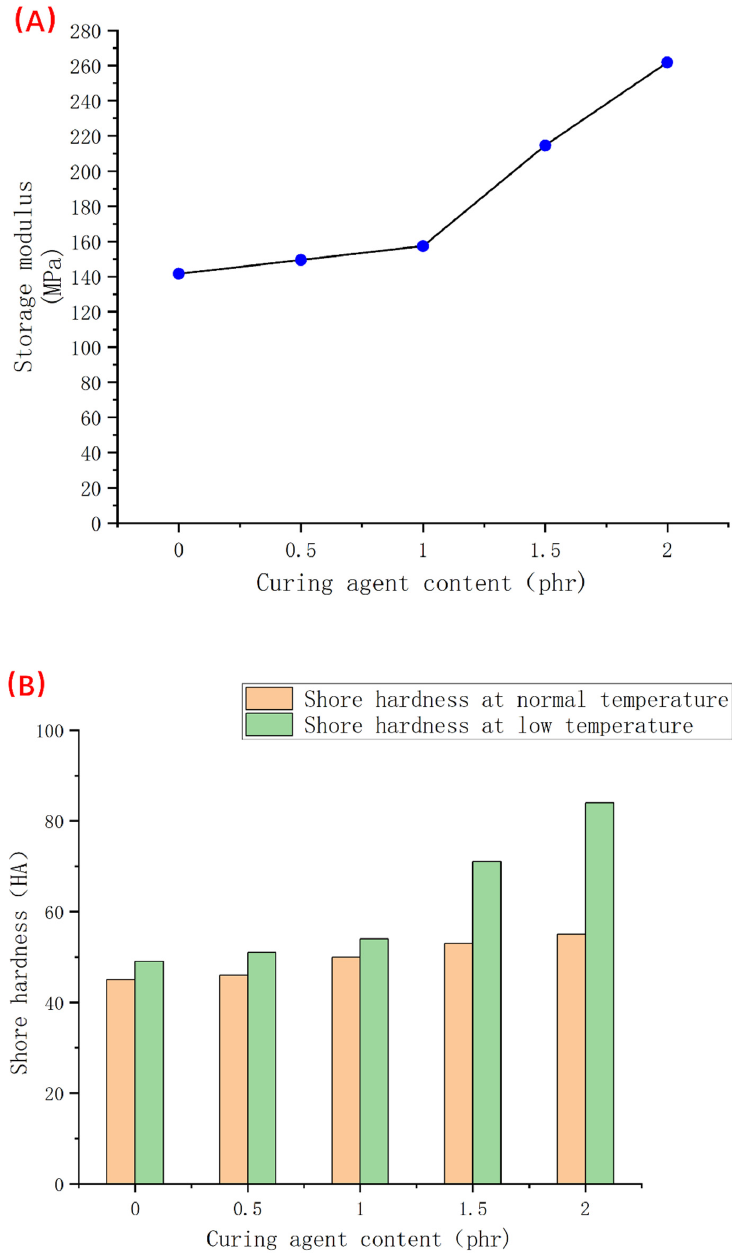
Figure 11. Low-temperature hardness change of samples 1–5 at − 60 ◦ C and broken line statistic diagram of the storage modulus at − 60 ◦ C (( A ) is the broken line statistic diagram of the storage modulus at − 60 ◦ C and ( B ) is the column diagram of low-temperature hardness change at − 60 ◦ C).